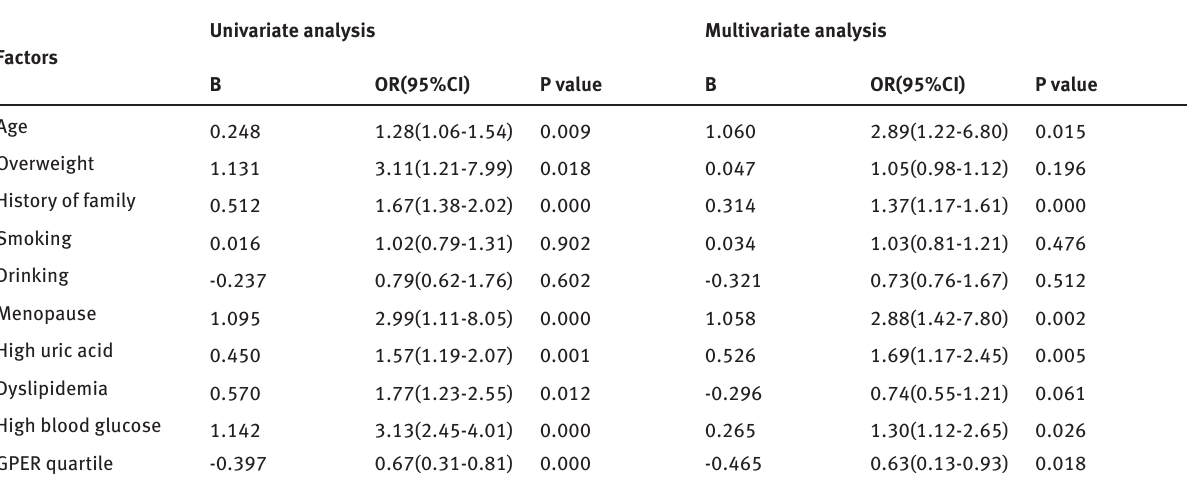
Table 2: Logistic regression analysis results for female hypertensive patients